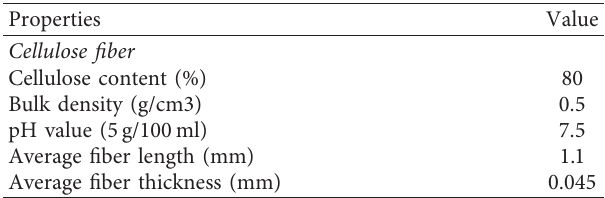
Table 4: Fibers’ characteristics.